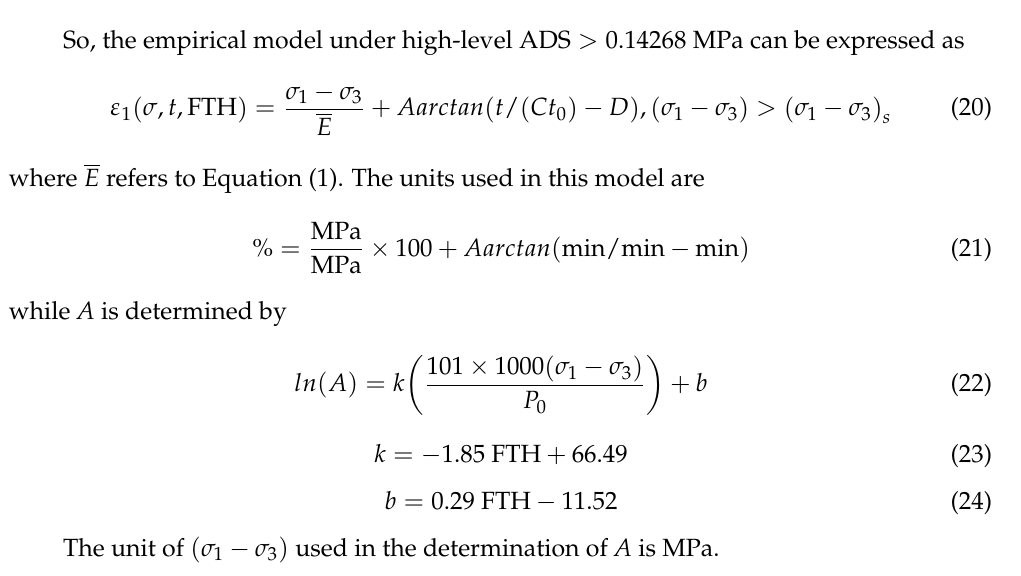
Figure 36. The correlation among k , b and FTH .